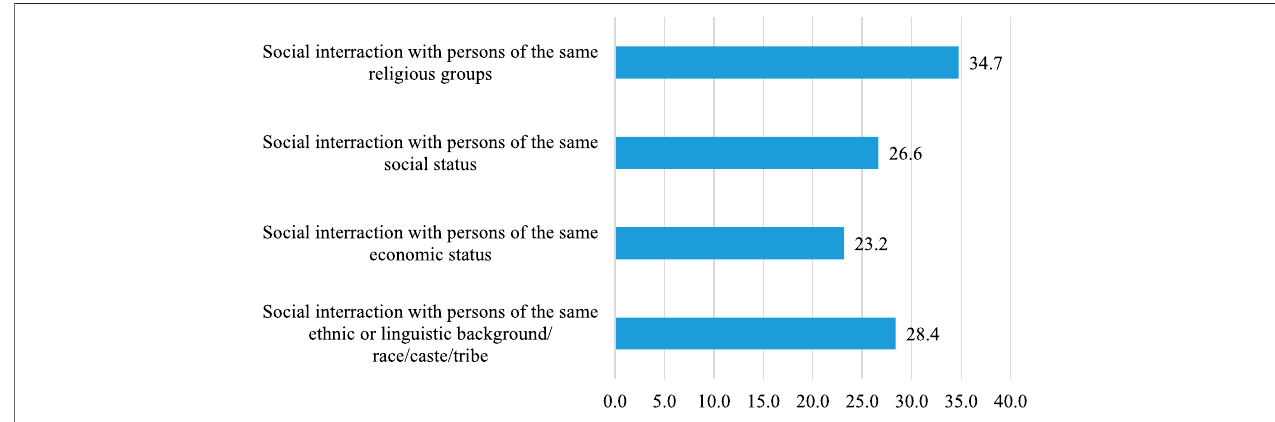
FIGURE 4 | Percentage distribution of bonding social interactions among SSA migrants in Germany ( N (cid:1) 518).